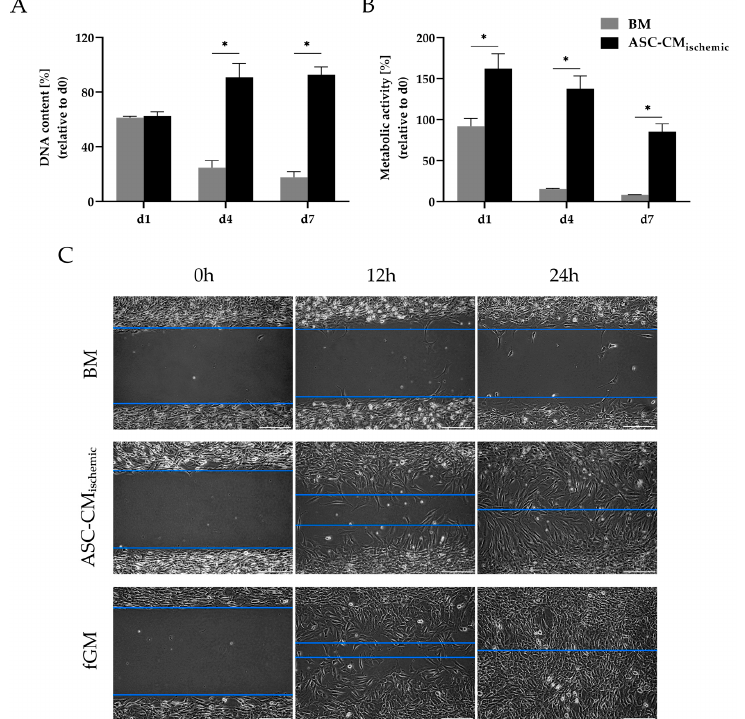
Figure 8. E ff ect of conditioned medium of glucose / oxygen-deprived ASCs (CM ischemic ) on proliferation, metabolic activity, and migration capacity of NIH / 3T3 fibroblasts. ( A ) Quantitative determination of total DNA content in relation to the mean value of day 0. ( B ) Metabolic activity as determined by a MTT assay. MTT accumulated in fibroblasts was solubilized and the optical density was measured at 570 nm; % metabolic activity was calculated in relation to the mean value of day 0. Data are presented as means ± SD of n = 3; * p < 0.05. ( C ) Migration of fibroblasts in conditioned medium from glucose / oxygen-deprived ACSs in comparison to the basal medium. Fibroblast growth medium served as a positive control. Representative micrographs at 0, 12, and 24 h were chosen for illustration, blue lines indicate the migration front. Scale bar represents 200 µ m. Data are presented as means ± SD of n = 3; * p < 0.05. Abbreviation: MTT: 3-(4,5-dimethylthiazol-2-yl)-2,5-diphenyltetrazolium bromide; BM: Basal medium, ASC-CM ischemic : Adipose-derived stem cell-conditioned medium of glucose / oxygen-deprived ASCs; fGM: Fibroblast growth